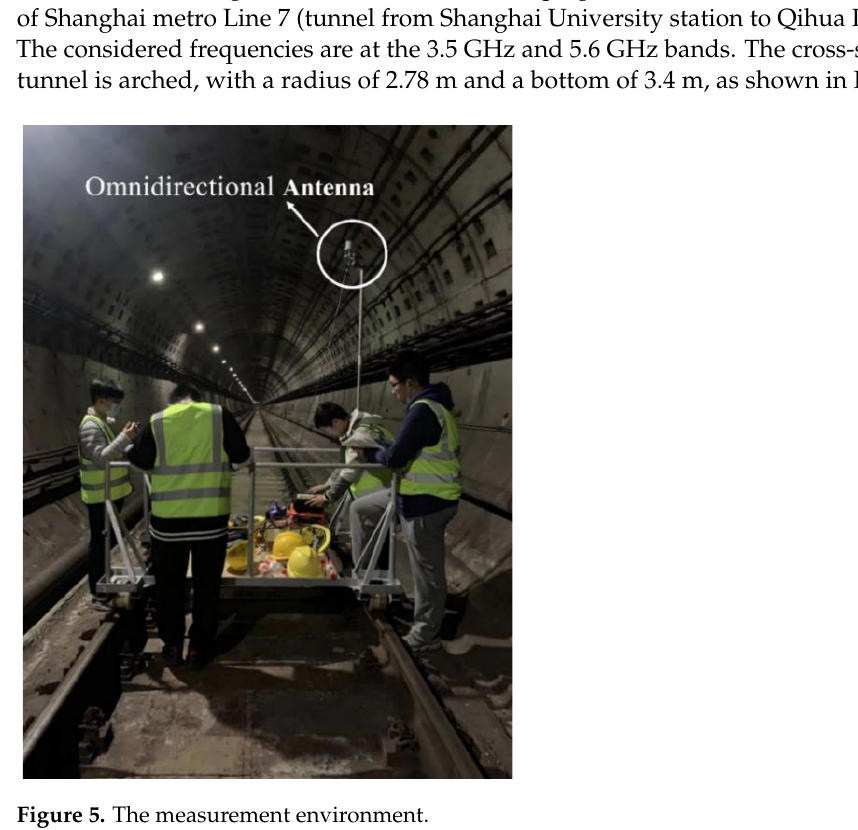
Figure 5. The measurement environment.